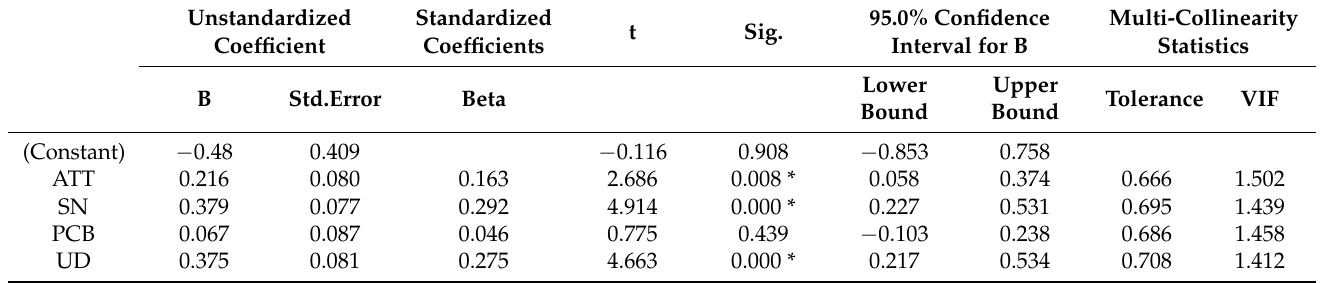
Table 7. Multivariate linear regression of the model